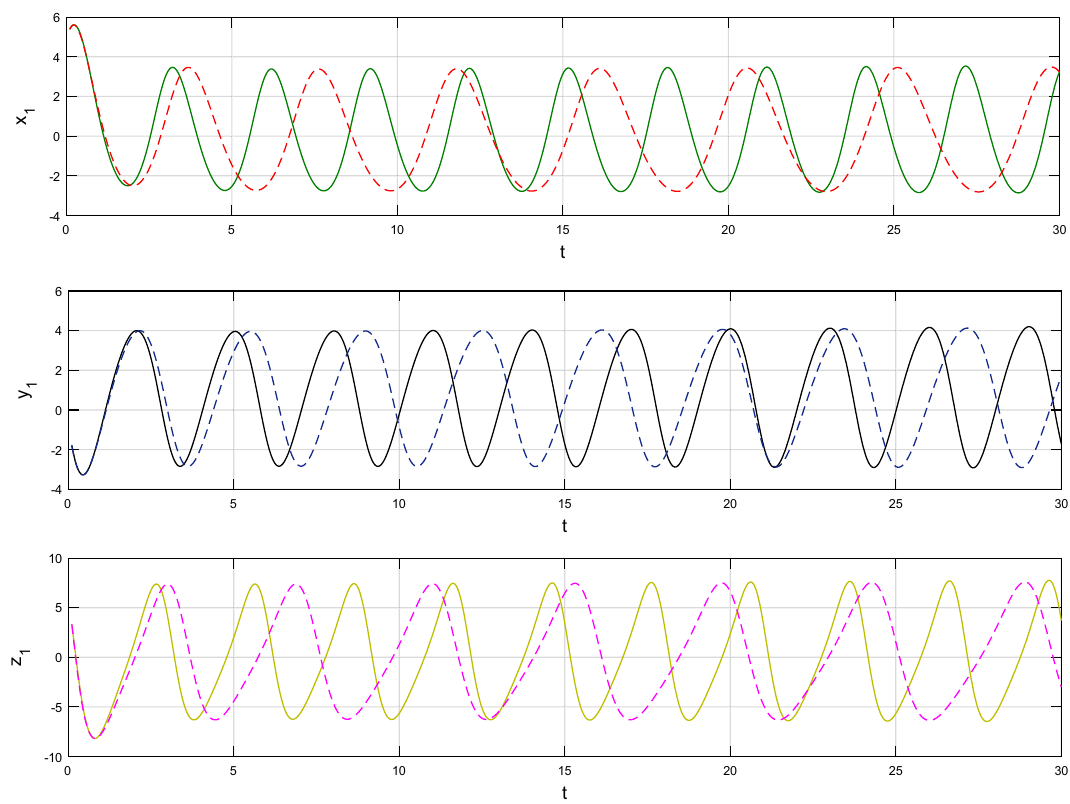
Figure 11. An analysis of the chaotic attractors for this case when β = 1 (line) and β = 0.90